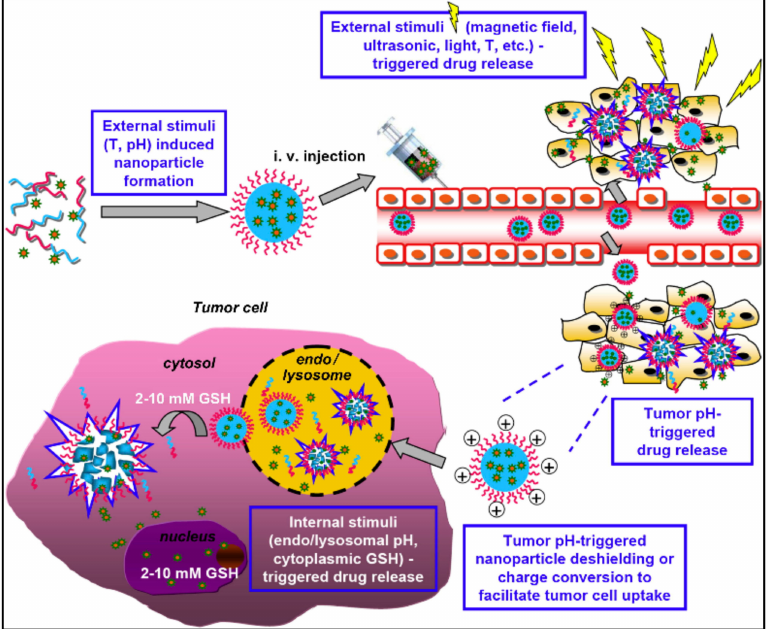
Figure 6. Emerging drug delivery systems based on stimuli responsive polymeric nanomicelles (i) formation of micelles through pH and temperature external stimulus application; (ii) drug release; (iii) enhancing cell uptake of drugs and release under acidic effect; and (iv) strong redox potential is used to increase intracellular drug release inside cancer cells. Reprinted with permission from [135]. Copyright © 2013,